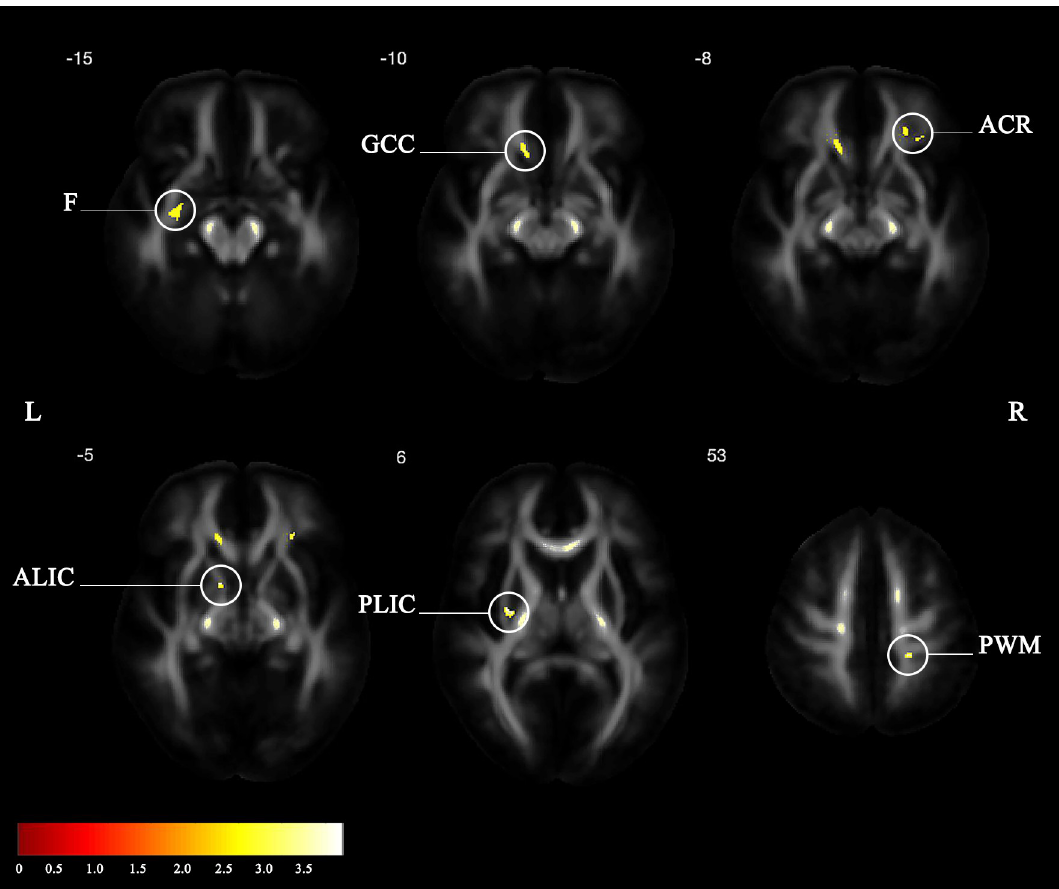
Fig 3. Statistical parametric maps of the group-by-time interaction for the white matter FA. (F: Fornix; GCC: Genu of corpus callosum; ACR: Anterior corona radiata; ALIC: Anterior limb of internal capsule; PLIC: Posterior limb of internal capsule; PWM: Parietal white